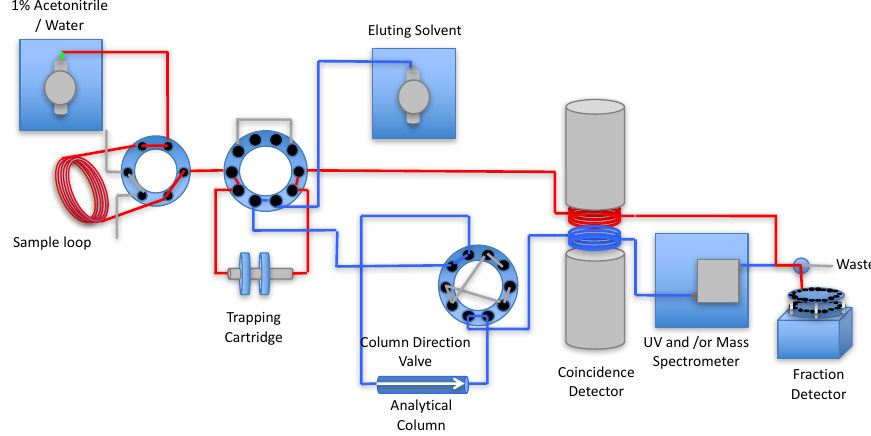
Figure 4. The loading of the plasma from the sample loop to the trapping cartridge while the analytical column continues to be equilibrated with the eluting solvent.